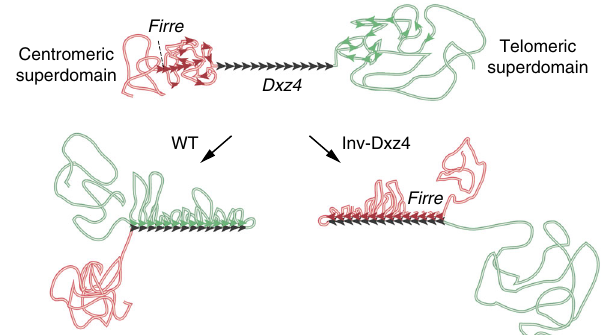
Fig. 10 Model for the role of Dxz4 in unidirectional contacts with other loci on the Xi. Diagram of the Dxz4 locus (black) with adjacent centromeric (red) and telomeric (green) superdomains of the Xi. The orientation of CTCF-binding motifs is shown with black arrows, with 14 motifs being represented. Potential CTCF sites located in the telomeric superdomain are shown as green arrows, and on the centromeric domain as red arrows. In WT cells contacts between Dxz4 and loci telomeric to the locus would result in the formation of loops anchored at Dxz4 by the correct alignment of CTCF motifs, which would stall cohesin rings that continuously extrude loops (not depicted). Dxz4 would be pulled to the telomeric end of the hinge. After Dxz4 inversion contacts would shift to the centromeric superdomain, and be especially enhanced between Dxz4 and Firre . A new de-condensed hinge would form, with Dxz4 located at its centromeric end. Note that in WT and Inv-Dxz4, loops are depicted as anchored at each CTCF-binding site on Dxz4 . However, the process of loop formation is not static, but rather highly dynamic; thus, at a given time not all loops are likely to be anchored and larger or smaller loops may